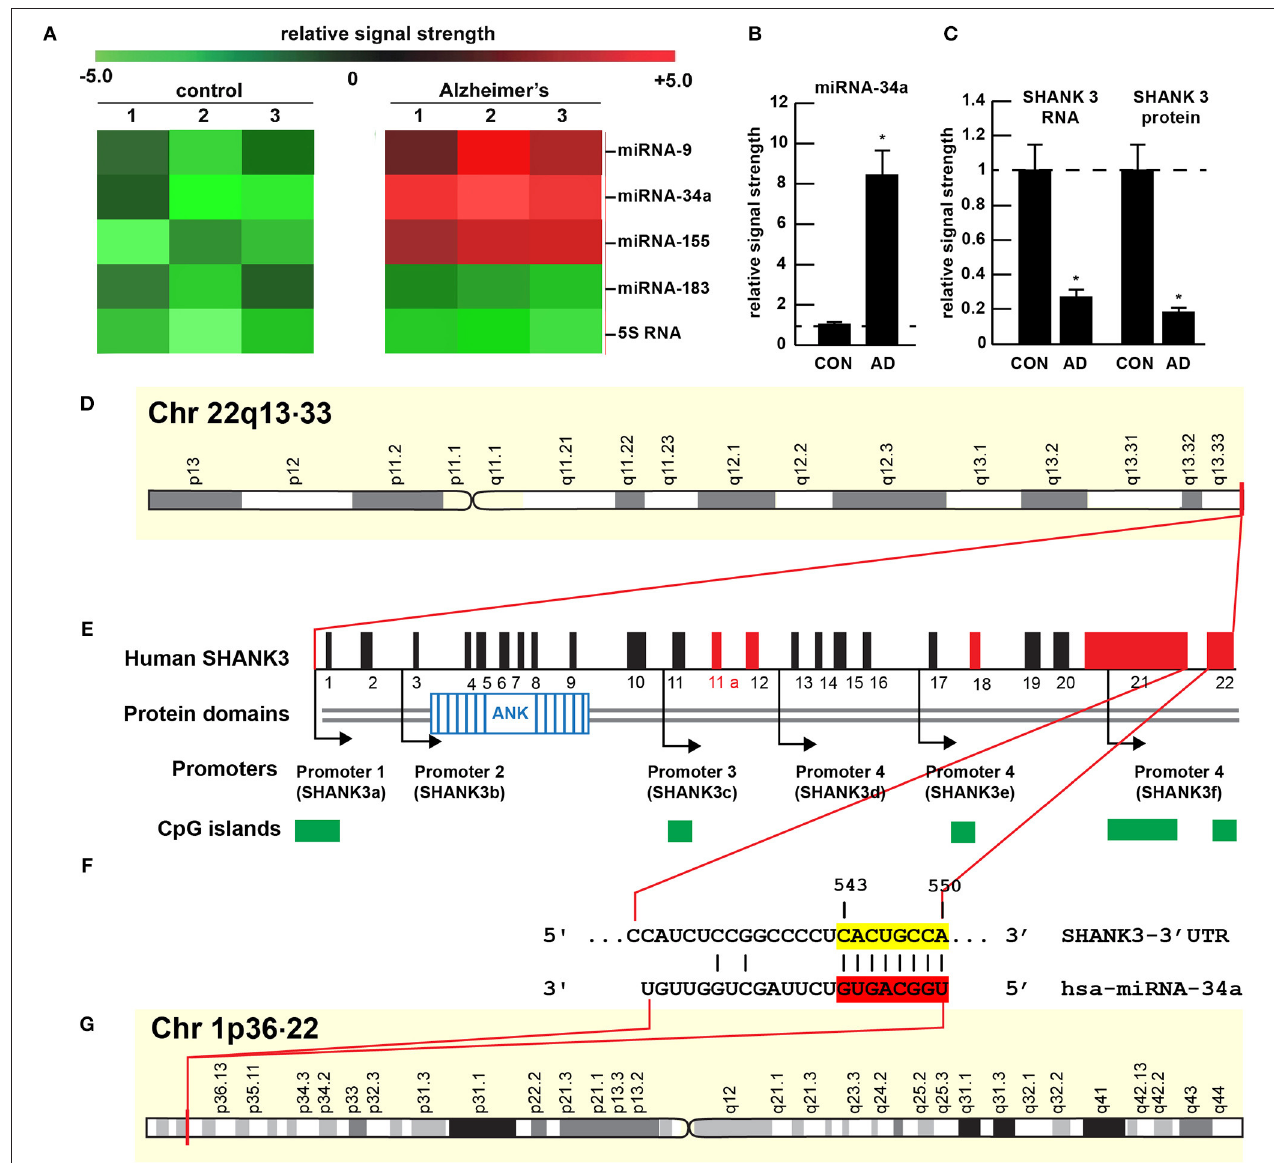
FIGURE 1 | Gene products on human chromosomes 1 and 22 interactively contribute to SHANK3 expression in CNS tissues. (A) Results of miRNA microfluidic array analysis; miRNA-34a is significantly up-regulated in the sporadic AD temporal lobe compared to miRNA-183 and 5S RNA control sncRNA markers; the numbers 1–3 indicates 3 separate control and age-matched AD cases; all female; control mean age 72.1 ± 6.6 years; AD mean age 73.8 ± 8.2 years; N = 3 control and 3 AD: all post mortem intervals < 3h; (B) quantitation of miRNA-34a levels in bar graph format; (C) quantitation of SHANK3 mRNA (using Northern analysis) and SHANK3 protein (using ELISA) in the superior temporal lobe of control and AD as previously described (9, 23); N = 3; * p < 0.001 (ANOVA). (D–G) highly schematicized depiction of the human SHANK3 gene organization at chr 22q13.33 and the human miRNA-34a gene organization at chr 1p36.22; with a P CT (probability of conserved targeting) or Friedman score of 83 [(24); that has been calculated for all highly conserved miRNA families]; this hsa-miRNA-34a-SHANK3-3 ′ -UTR recognition/interaction is highly favorable and almost certain to occur in the cytoplasm/nucleoplasm of CNS cells; (E) has been modified from (25); the homo sapien (hsa) microRNA-34a (hsa-miRNA-34a) is encoded from the distal end of human chromosome 1p (at chr 1p36.22) and generates a 22 nt mature miRNA-34a species; hence the expression of at least two genes, one cytoskeletal and structural (SHANK3) and one regulatory (miRNA-34a) on human chromosomes 1p and 22q is required for regulating the expression of